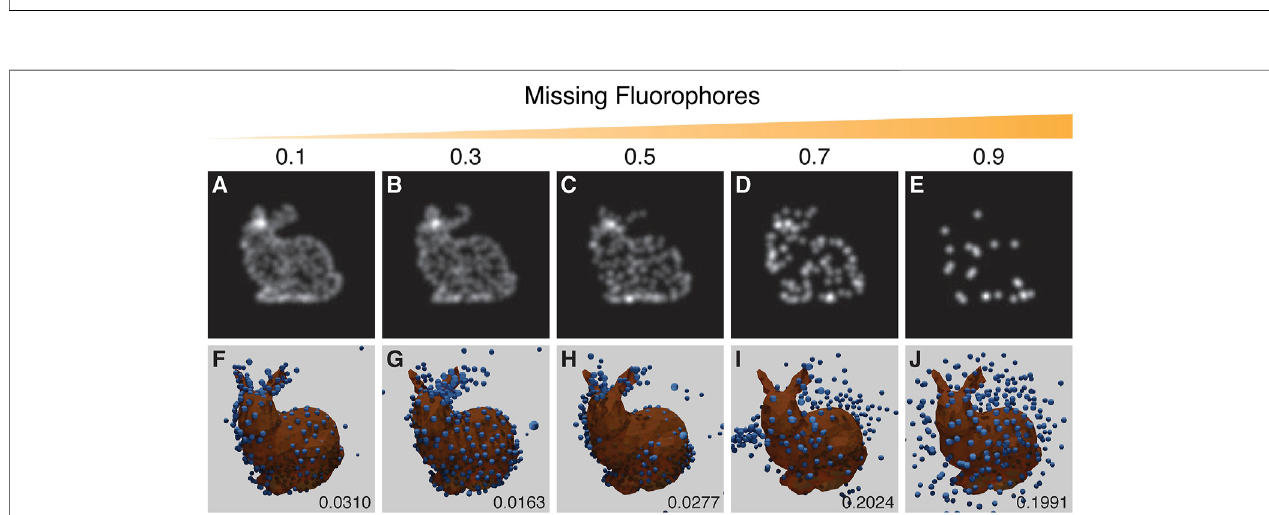
FIGURE 8 | Results from the experiment on the effect of missing fl uorophores. Top row (A – E) : examples of training images with increasing probability of removing points as indicated by the value above each panel. Bottom row (F – J) : the corresponding results with the inferred structure shown as blue spheres, overlaid and aligned withthegroundtruthmodelinorange.ResultingRSMDscoresforeachrunareindicatedinthelowerrightcornerof(F – J).Therunin (G) showedanincorrectsymmetrical structure whereas the run in (H) showed mirroring in a vertical plane. The parameters for this experiment can be found in Supplementary Table S5.5